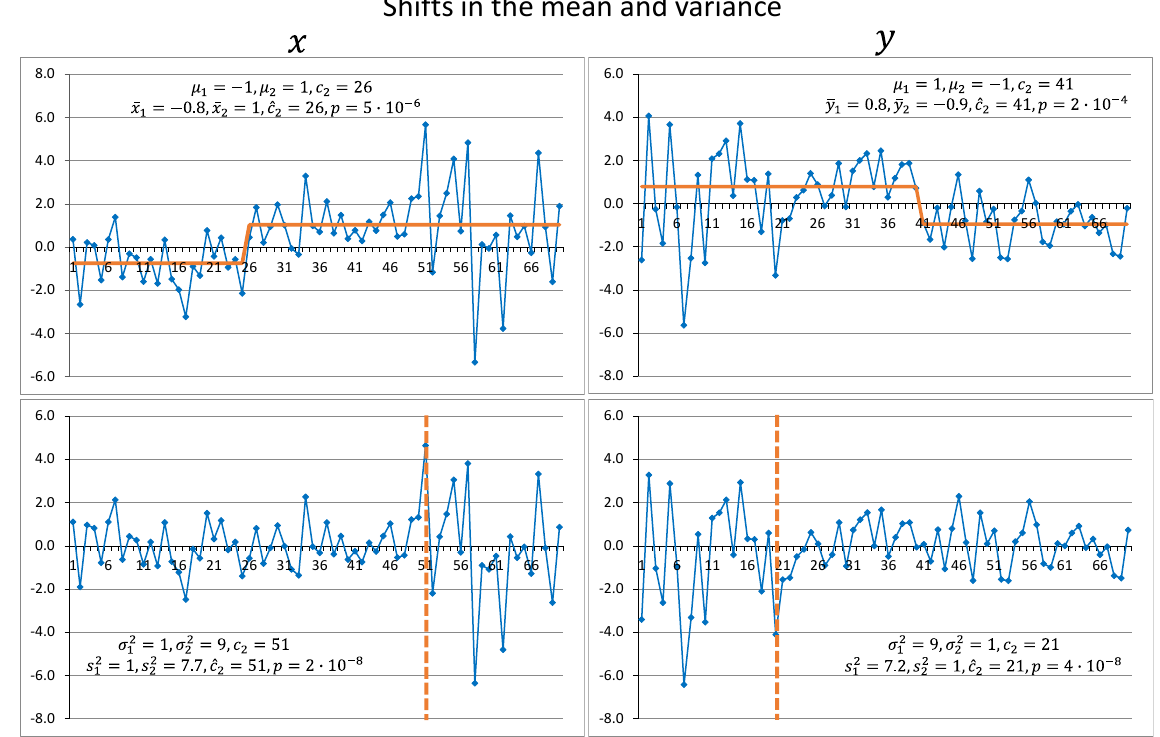
Figure 3. Regime shifts detected in the mean ( top row ) and variance ( bottom row ) in time series 𝑥 ( left column ) and 𝑦 ( right column ). In all four cases the detection is performed with the target significance level 𝑝 = 0.05 and cut-off length 𝑙 =